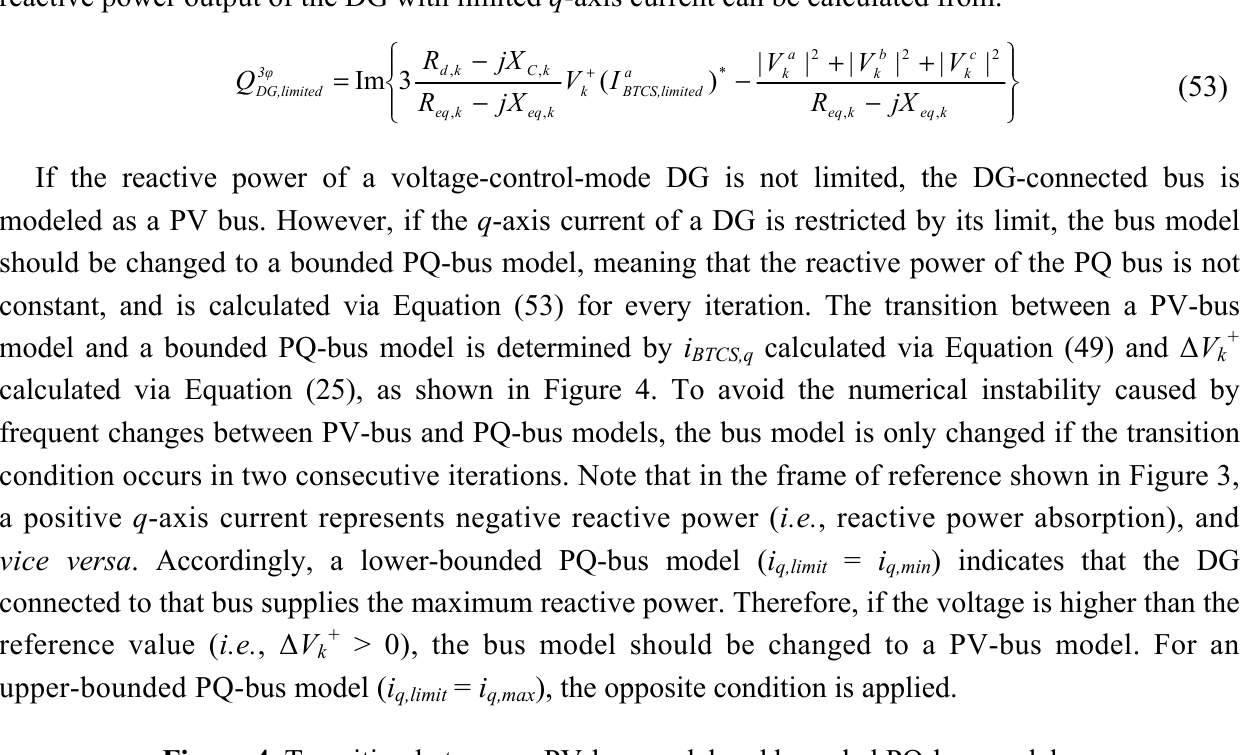
Figure 4. Transition between a PV-bus model and bounded PQ-bus